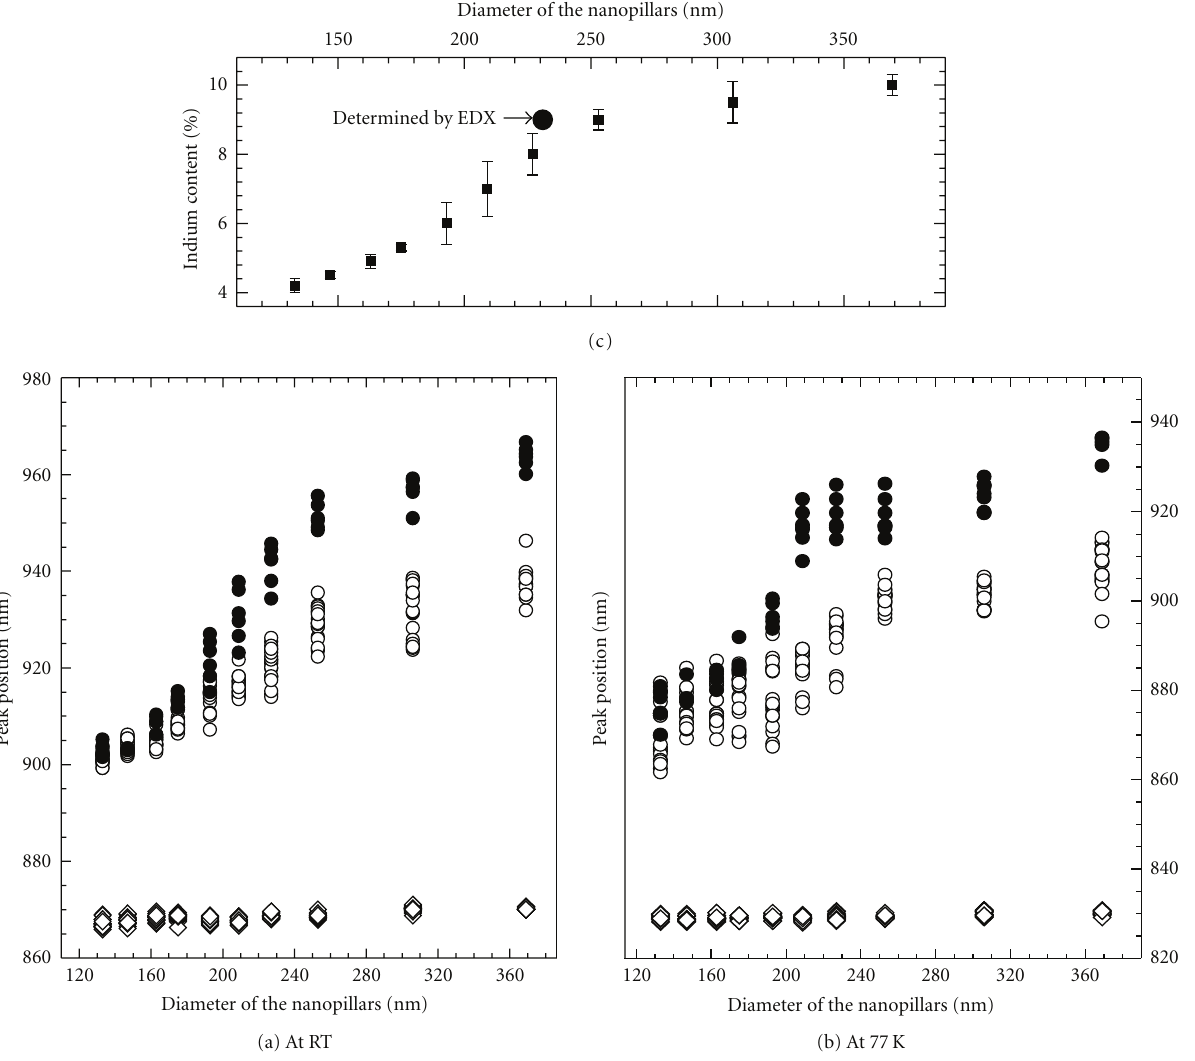
Figure 6: (a) Dependence of PL peak position on diameter of nanopillars at RT and (b) at 77K. Dependence of indium content on diameter of nanopillars (c). Open diamonds stand for band-edge emission of GaAs barrier layer in sample I, open circles for first electron heavy hole excitonic recombination of InGaAs/GaAs QW in sample I, and filled circles for band-edge emission of InGaAs layer in sample II